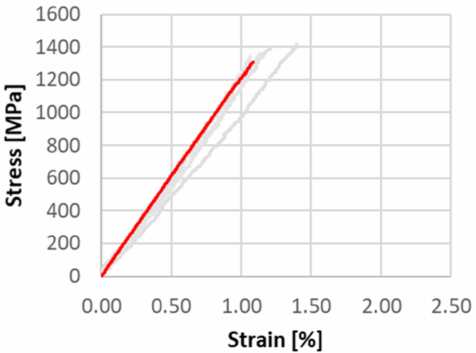
Figure 12. Tensile stress-strain-curve (grey-experiments; red-simulation).